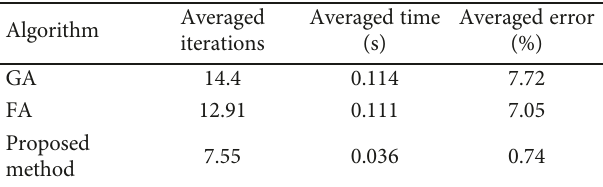
Table 9: Tracking speed and tracking accuracy comparison of the GA, FA, and proposed